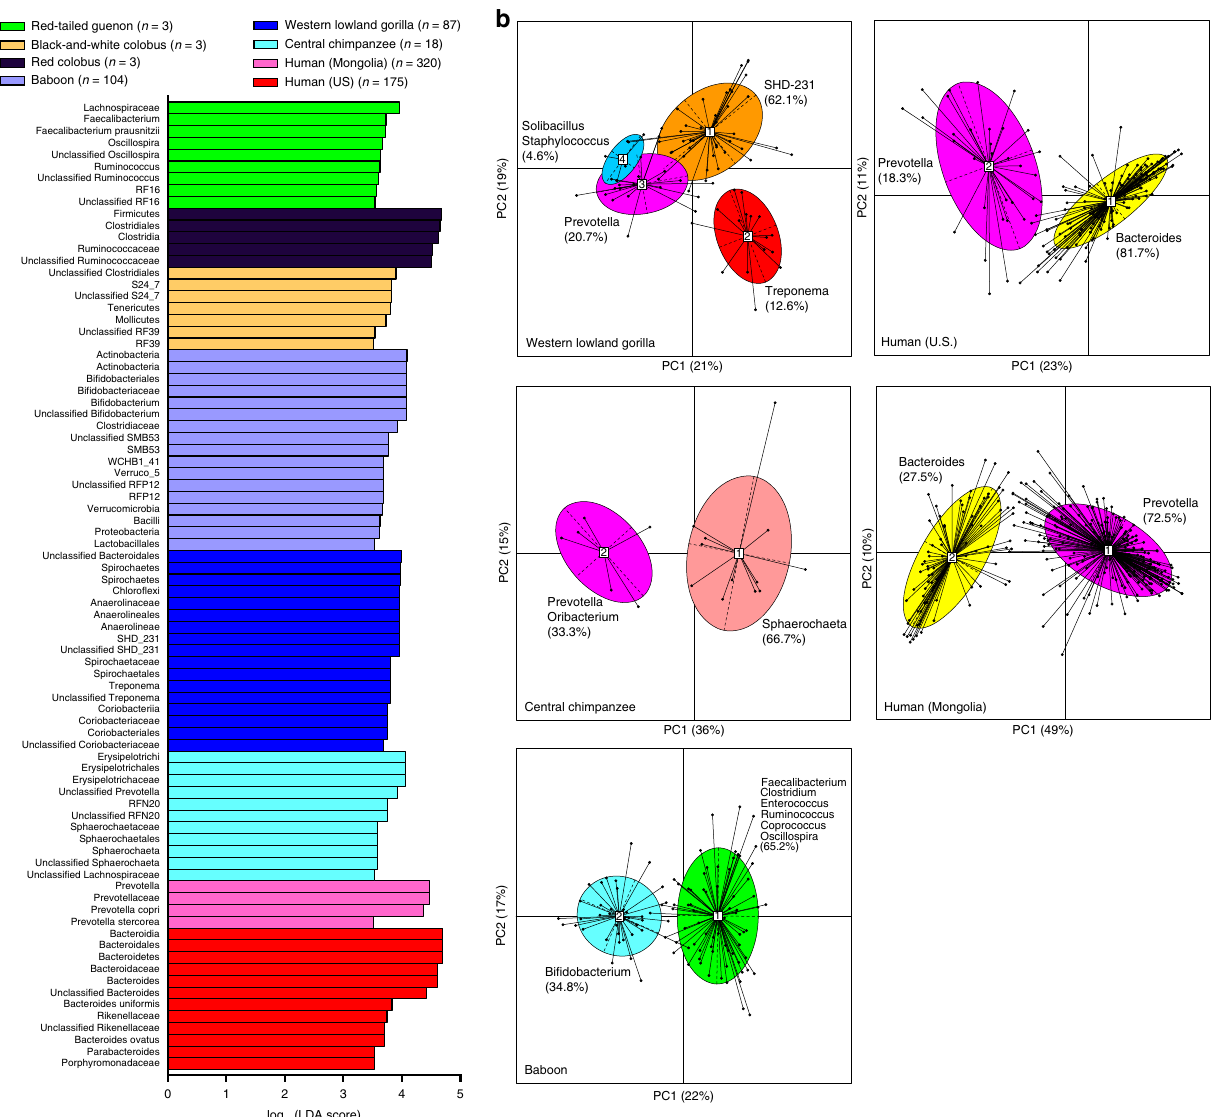
Fig. 2 The relative abundance of fecal bacterial taxa and enterotype clusters distinguish WLGs, sympatric chimpanzees, Old World monkeys, and two human populations. a Bar chart showing the log-transformed LDA scores of bacterial taxa of each NHP or human host type identi fi ed by LEfSe analysis. Note that while a log-transformed LDA score of 2 was used as a threshold for identi fi cation of signi fi cant taxa, LEfSe analysis of this dataset yielded 377 taxa. Therefore, only bacterial taxa with LDA score ≥ 3.5 are shown (see Supplementary Data 5 for all associated taxa). b Principal coordinate analysis plots based on rJSD among genus-level relative abundance distributions with the four WLG, two chimpanzee, two baboon, two Mongolian human, and two US human enterotypes identi fi ed by PAM analysis indicated. Numbered white rectangles indicate the centroid of each cluster, while solid black lines indicate the distance of each sample from the centroid of the cluster. De fi ning genera of each enterotype identi fi ed by BCA and LEfSe analysis (see Supplementary Fig. 5n – r) are indicated along with the percentage of samples from the dataset that was assigned to each